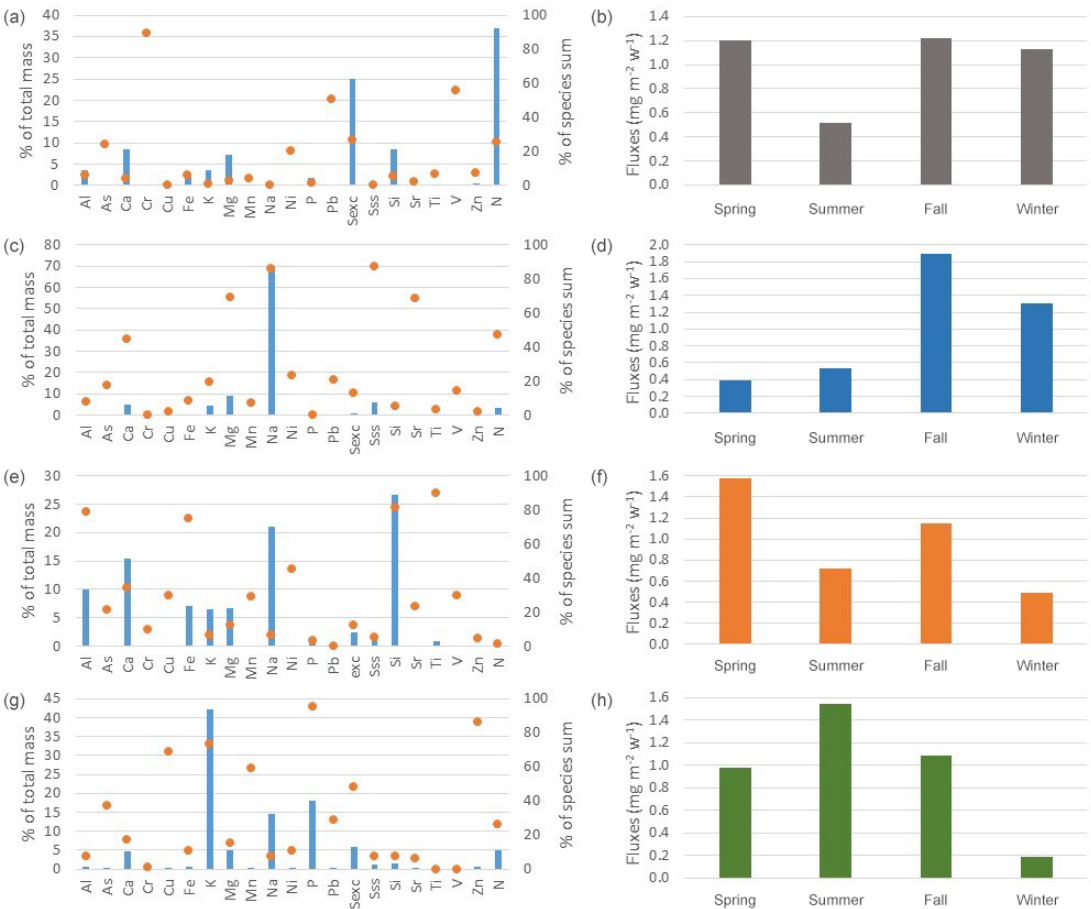
Figure 5. PMF-derived profiles of the four sources identified. From top to bottom: (a) anthropogenic, (c) marine, (e) dust, and (g) biomass burning including the fraction of total mass (blue columns) and fraction of the elemental sum (orange circles) for the various elements (left side). Normalized seasonal contributions of these four respective factors (b, d, f, h) , excluding the 10 most intense dust events (right